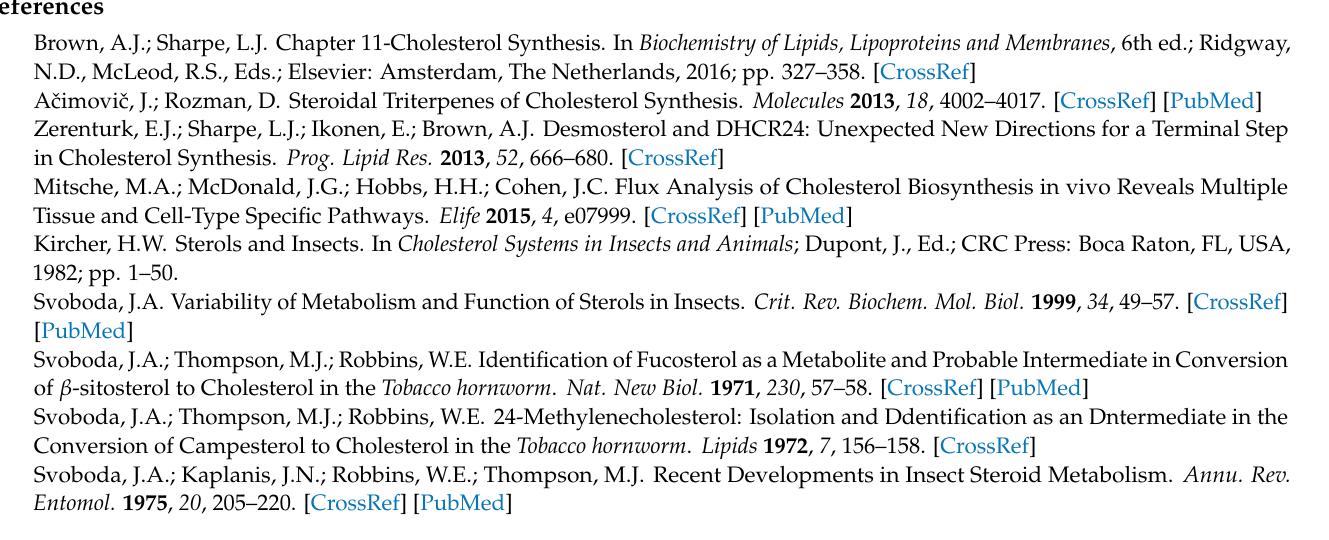
Figure S1: Mass spectra of TMS derivatives of commercial samples of cholesterol and cholesterol-d7, Figure S2: Effects of different amounts of azacosterol on the enzyme activity in the 15,300 × g -pellet fraction extracted from fat body and anterior midgut, Figure S3: Effects of azacosterol on the amount of desmosterol in fat body and anterior midgut, Figure S4: The efficiencies of the knockdown of GbDHCR24s, Figure S5: The alignment of GbDHCR24 showing the predicted phosphorylation